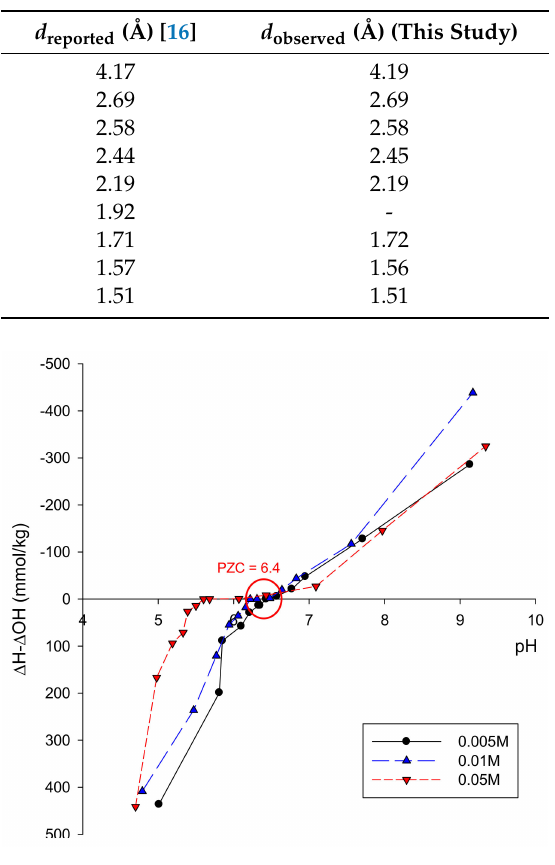
Figure 2. Point of zero charge (pzc) of the synthesized